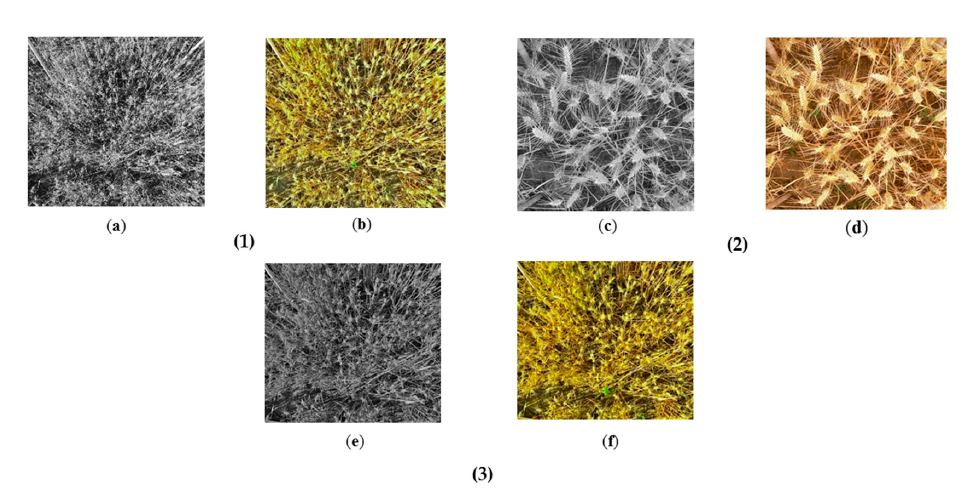
Figure 5. Fusion results of original panchromatic and multispectral images after registration. (1) Image contrast before and after fusion in T1 plot: ( a ) Panchromatic image with T1 plot; ( b ) Fusion result in T1 plot; (2) Image contrast before and after fusion in T3 plot: ( c ) Panchromatic image with T3 plot; ( d ) Fusion result in T3 plot; (3) Image contrast before and after fusion in T4 plot: ( e ) Panchromatic image with T4 plot; ( f ) Fusion result in T4 plot